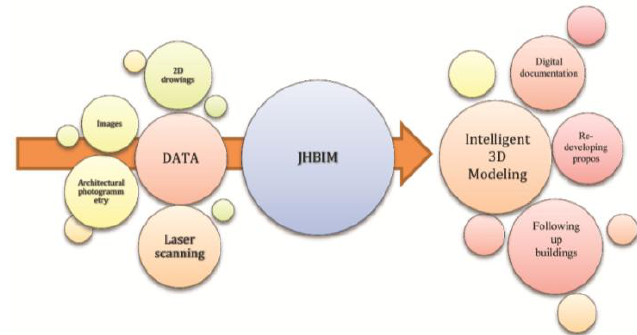
Figure 13. The approach of JHBIM.